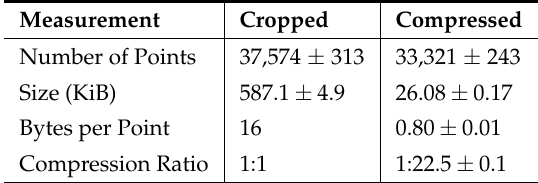
Table 4. Octree compression results, 2cm octree resolution. The results are mean values over 1000 measured point clouds, with the number of points rounded to the nearest